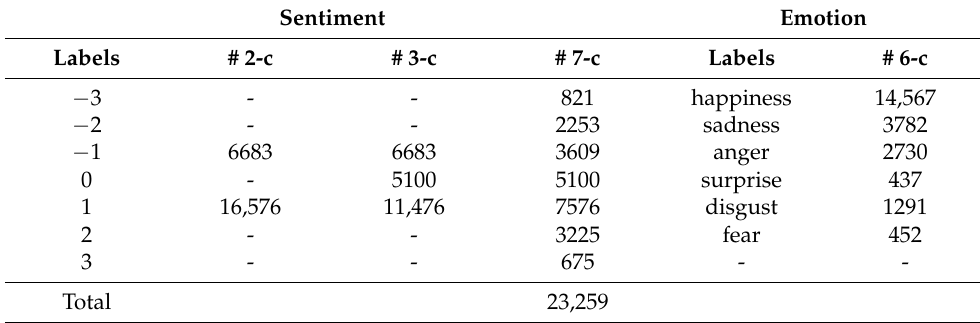
Table 1. Distribution of samples for each sentiment and emotion label for different classes (c).